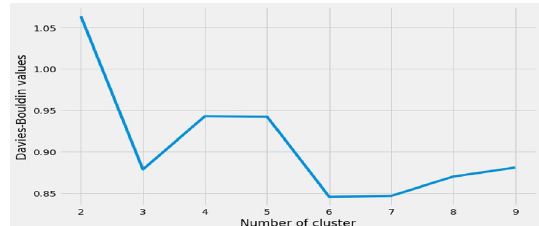
Fig. 10 DB plot for all n -clusters